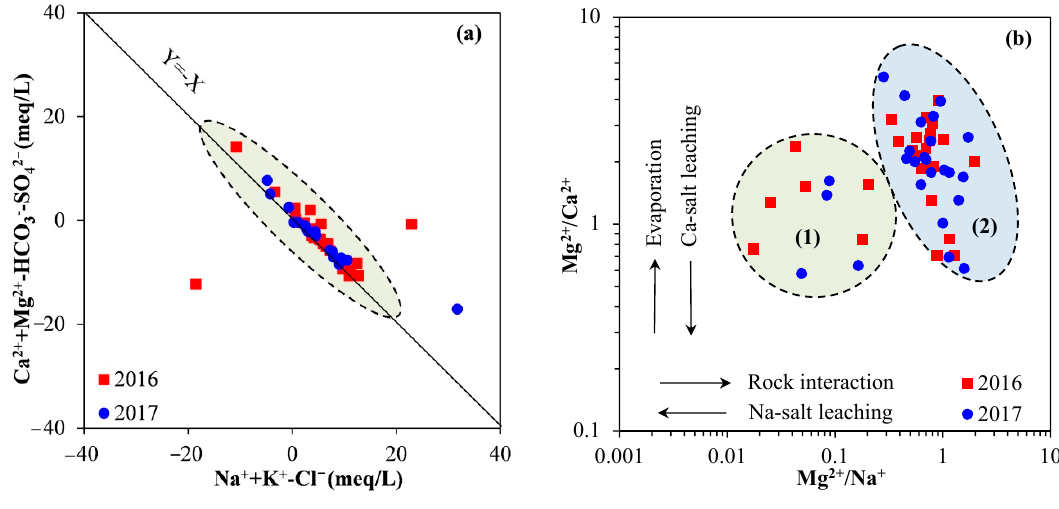
Figure 5. Plots showing ( a ) (Ca 2 + + Mg 2 + − HCO 3 - − SO 4 2 − ) versus (Na + + K + − Cl − ) and ( b ) Mg 2 + / Ca 2 + versus Mg 2 + / Na + .